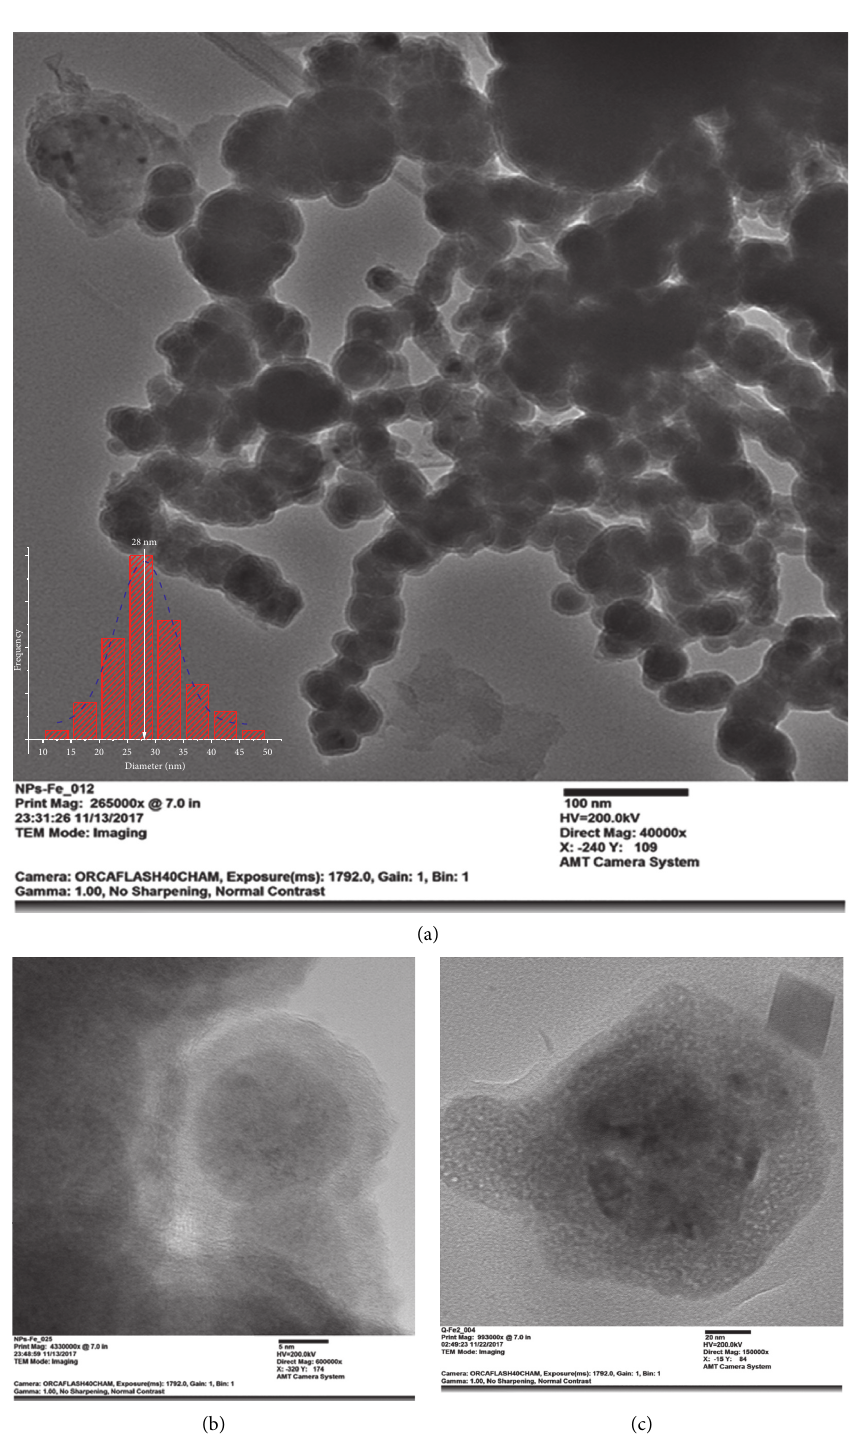
Figure 3: TEM: (a) fine particles of FeNPs; (b) ultrafine nanoparticles of FeNP core; (c) ultrafine nanoparticles of